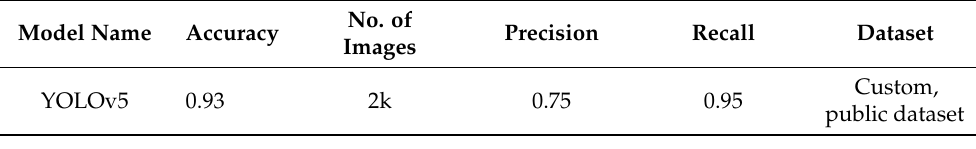
Figure 22. YOLOv5 experiment